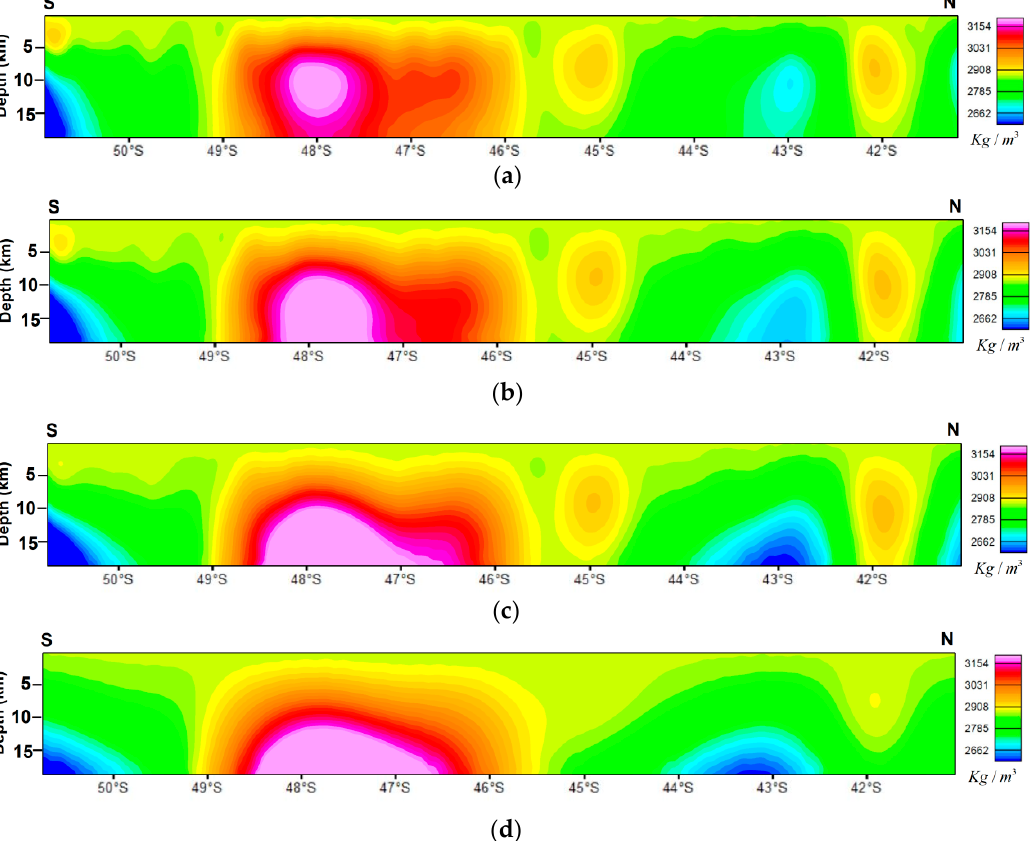
Figure A1. Some of the models that were recovered from changing the exponent of the Tikhonov parameter during 3D inversion for ( a ) 0.2, ( b ) 0.3, ( c ) 0.4, ( d ) 0.5, ( e ) 1 and ( f ) 1.5.